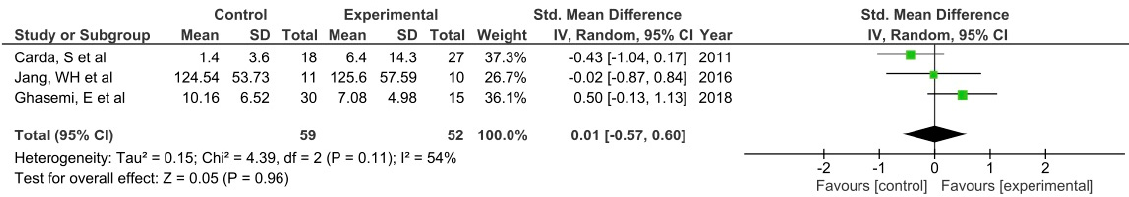
Figure 5. Forest plot of the comparison of the difference between the groups in ROM.